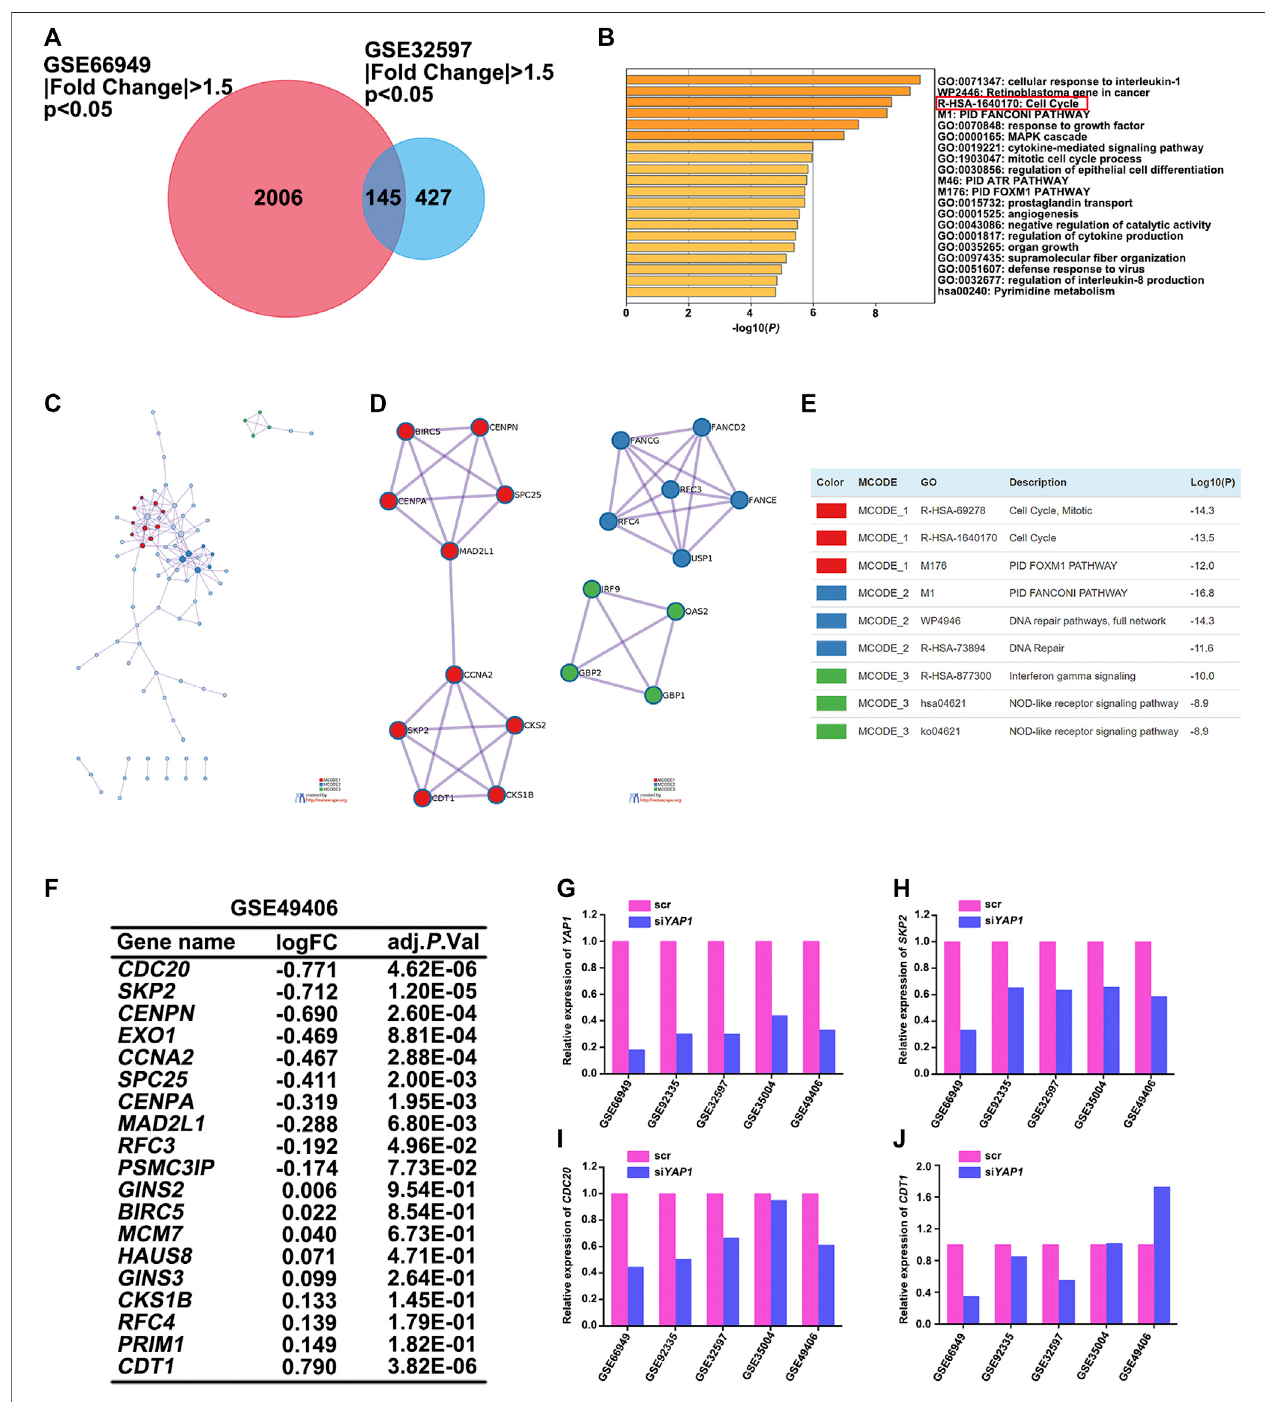
FIGURE 5 | SKP2 regulated by YAP participated in the cell cycle process of multiple tumors. (A) Identi fi cation of DEGs in mRNA expression pro fi ling datasets GSE66949 and GSE32597 with an adjusted p < 0.05, | Fold Change | > 1.5 as the cut-off criteria. Venn diagram displaying the overlap between DEGs from GSE66949 and GSE32597 datasets. (B) Metascape functional enrichment analysis of the overlapping DEGs between GSE66949 and GSE32597 cohorts. (C) A protein-protein interaction(PPI)networkoftheoverlappingDEGswasconstructedinMetascape. (D) ModulesselectedfromPPInetworkusingMCODE. (E) Thedescriptionofthe topthreeMCODEcomponents. (F) AnalysisoftheexpressionchangesofoverlappingDEGsparticipatedinthecellcycleprocessbetweenGSE66949andGSE32597in GSE49406. (G) The relative expression level of YAP1 between control and si YAP1 group in 5 GEO datasets. (H) The relative expression level of SKP2 between control andsi YAP1 groupin5GEOdatasets. (I) Therelativeexpressionlevelof CDC20 betweencontrolandsi YAP1 groupin5GEOdatasets. (J) Therelativeexpressionlevelof CDT1 between control and si YAP1 group in 5 GEO datasets.